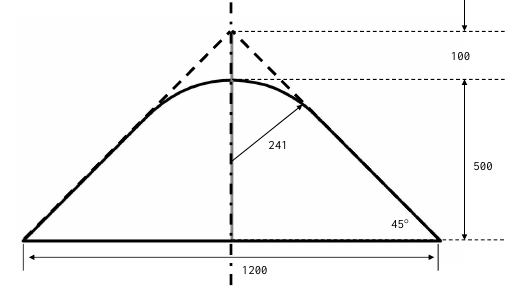
Figure 6: Technical drawing of the rock geometry/conical obstruc- tion. The illustration was made based on descriptions in [45, 46]